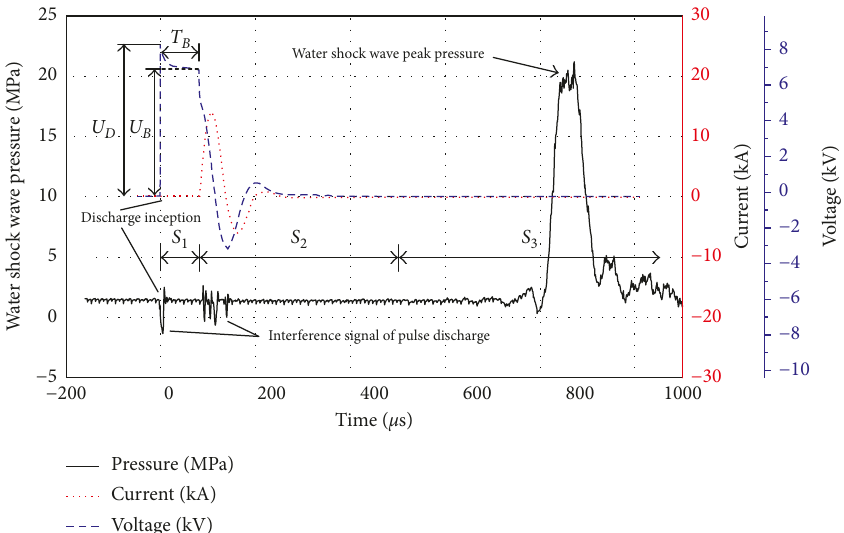
Figure 4: Diagram of the voltage, current, and pressure waveforms versus time for a typical HVPD process ( P